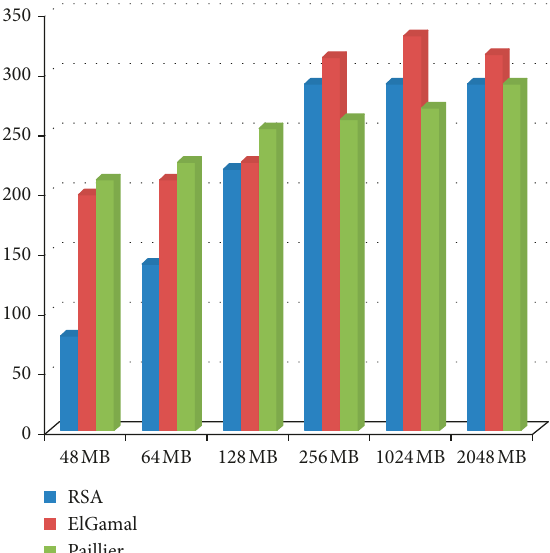
Figure 9: Time consumption during the decryption